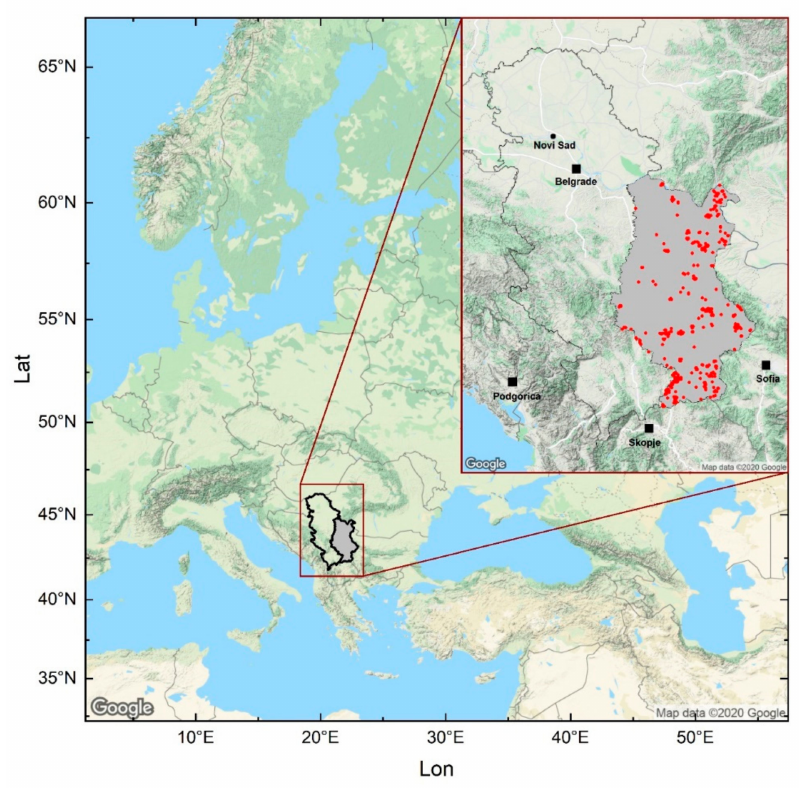
Figure 1. The geographic position of study area, Eastern Serbia, is marked in gray (latitudes 42.27– 44.82 ◦ N and longitudes 20.90–23.01 ◦ E) with the layer of forest fire hotspots obtained by